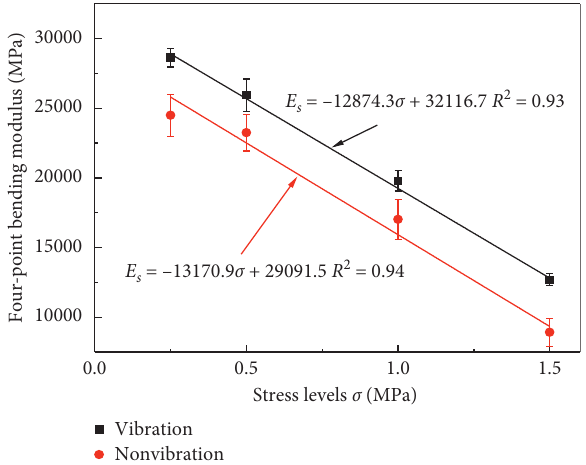
Figure 10: Four-point bending modulus of cement-treated aggregates affected by stress levels. Table 5: Coefficients of variation of fatigue lives under different stress